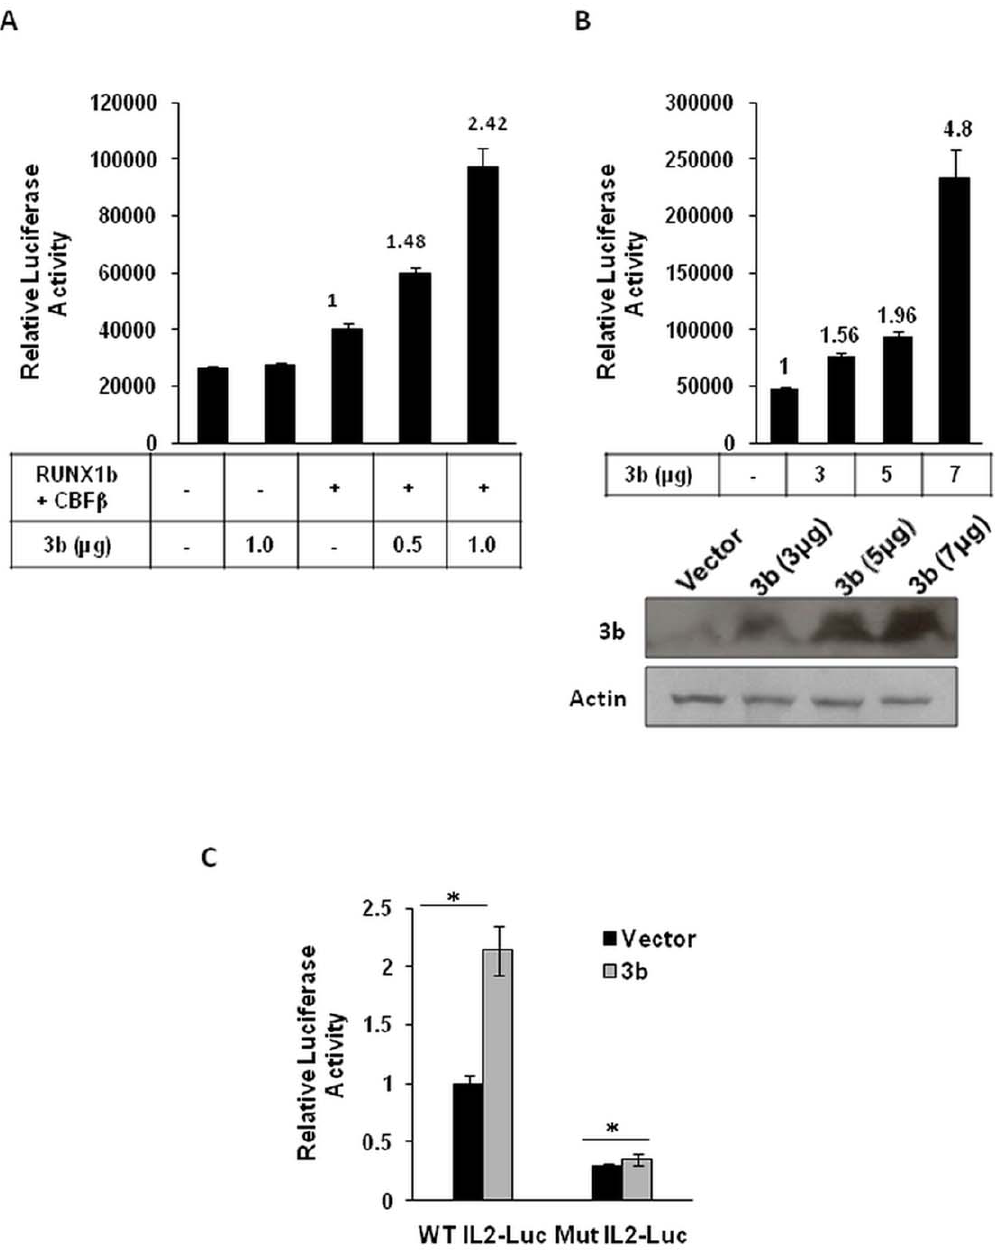
Figure 4. 3b increases RUNX1b transactivation potential on the mouse IL2 promoter. A. HEK293 cells were transfected with WT IL2-Luc plasmid alone or with Flag-RUNX1b, Flag-CBF b and indicated amounts of Myc-3b. Relative luciferase activities were calculated 48 h post transfection. B. Jurkat cells were transfected with WT IL2-Luc and indicated amounts of Myc-3b. Relative luciferase activities were calculated 48 h post-transfection. 3b expression was probed using a -myc antibody C. Jurkat cells were transfected with WT IL2-Luc or mutant IL2-Luc plasmid in the presence or absence of Myc-3b. Results in each panel are represented as mean 6 S.D. of triplicate cultures. Bar values represent fold increase in luciferase activity. *, p ,